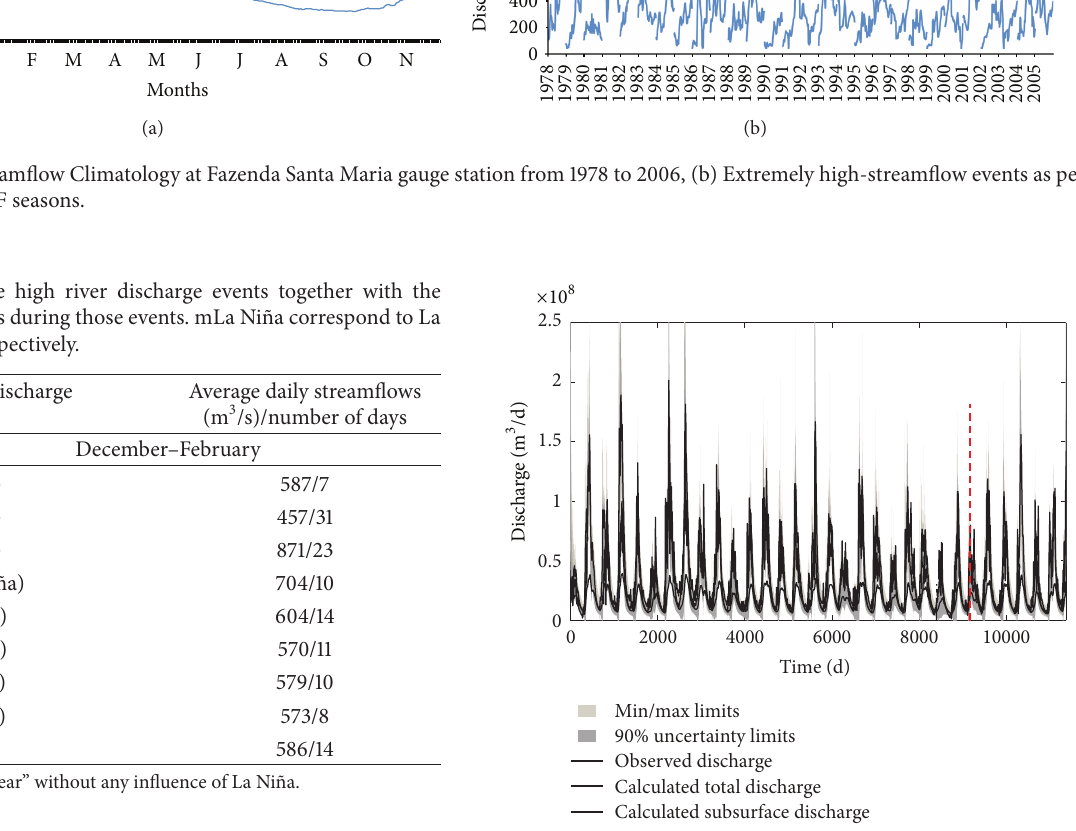
Figure 5: Model calibration ( Em = 0.54) and validation ( Em = 0.31) . Period at right from the red dashed line was used for model calibration (2001–2006). The entire period (1978–2006) was used for model